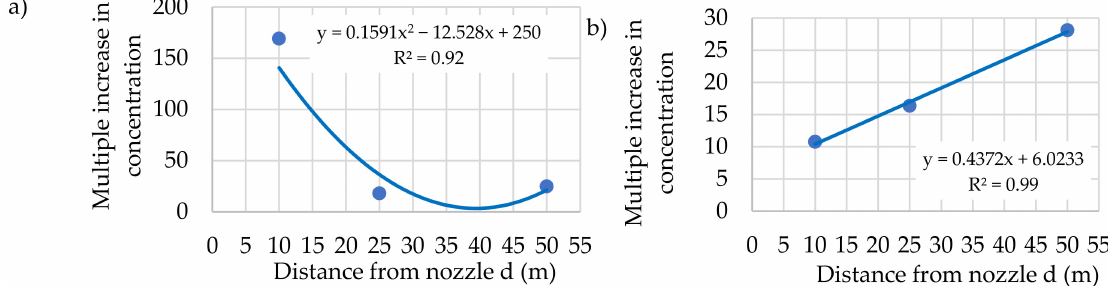
Figure 15. Distribution of changes in the concentration of coarse aerosols depending on the distance from the nozzle at the height above the floor: ( a ) 1.55 m, ( b ) 0.65